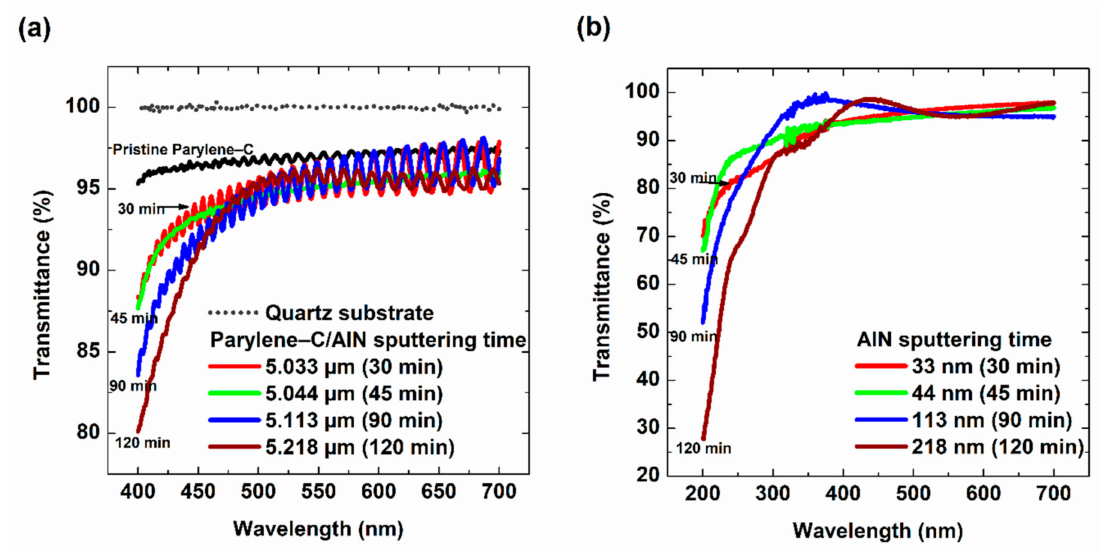
Figure 2. The transmittance spectra. ( a ) Quartz substrate (reference), pristine parylene-C and parylene-C/AlN samples, in the visible range. ( b ) Quartz substrate (reference) and AlN samples with respect to sputtering